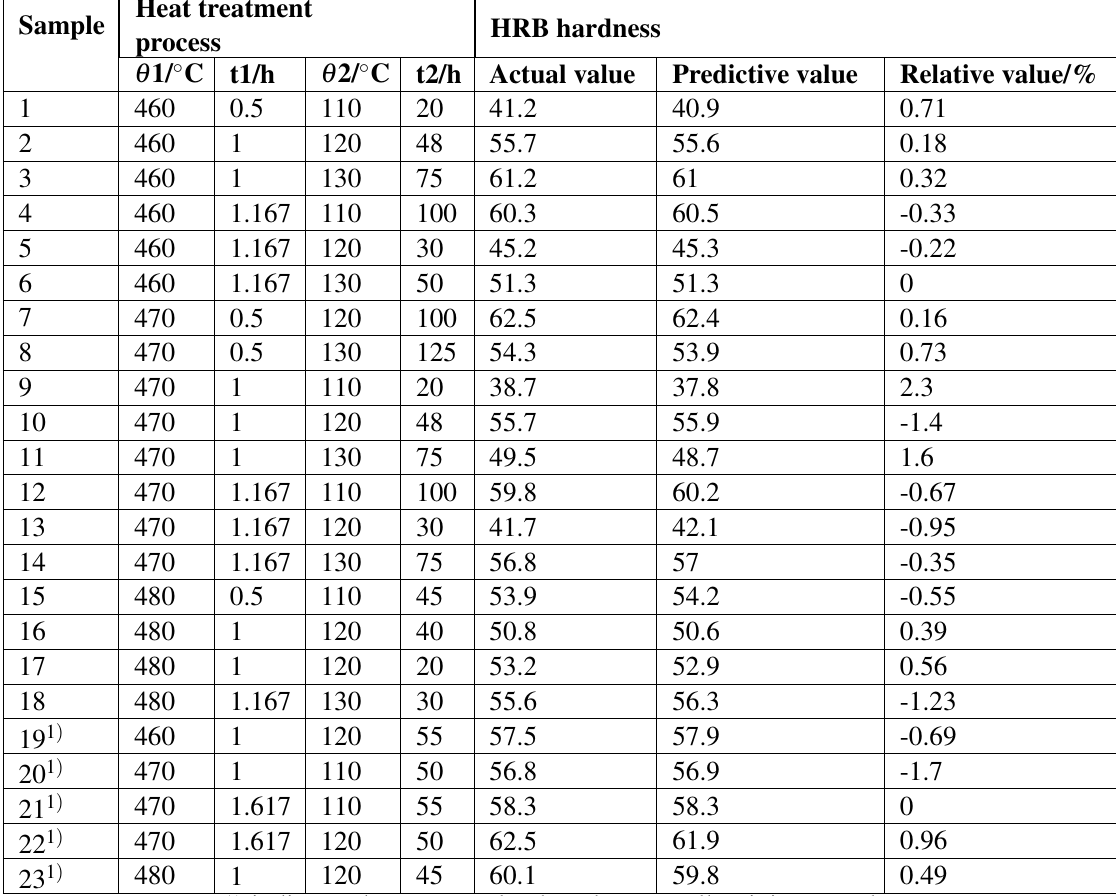
Table 1 Artificial neural network prediction points and verification